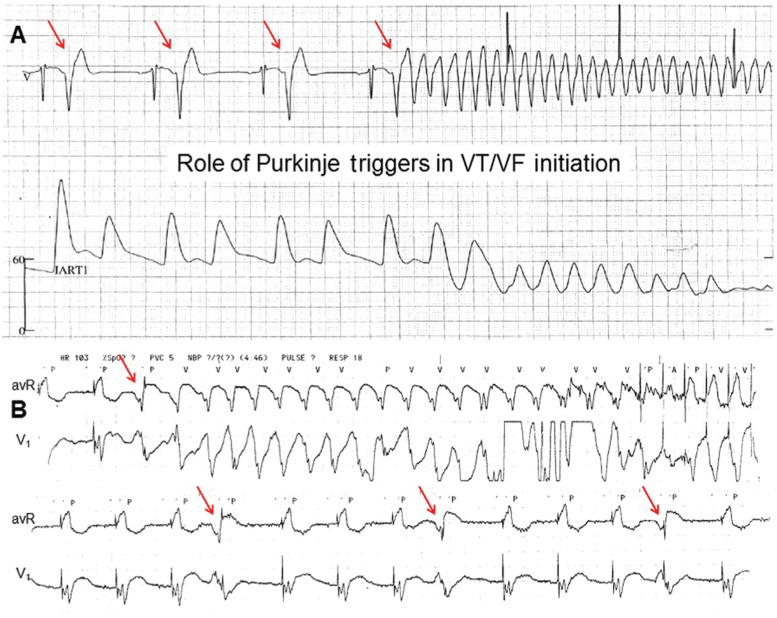
Purkinje-related ventricular tachyarrhythmias in ICM. A: Purkinje triggers manifested as closely coupled premature ventricular complexes (PVCs; arrows) for polymorphic VT or VF initiation. B: Purkinje fibers arborized along the infarct border may also serve as either a localized microreentrant or part of a macroreentrant circuit using the subendocardial scar substrate for monomorphic VT. This may manifest as frequent monomorphic PVCs (arrows). ICM: ischemic cardiomyopathy; VF: ventricuventricular fibrillation; VT: ventricular tachycardia.